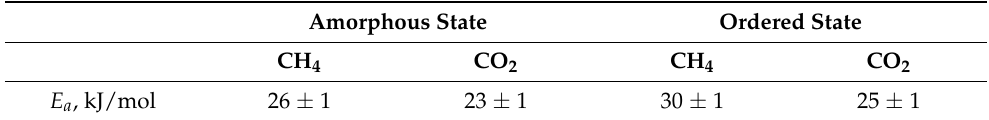
Table 1. Activation energy E a of diffusion of the CH 4 and CO 2 gases for BPDA-P3 in amorphous and ordered states.